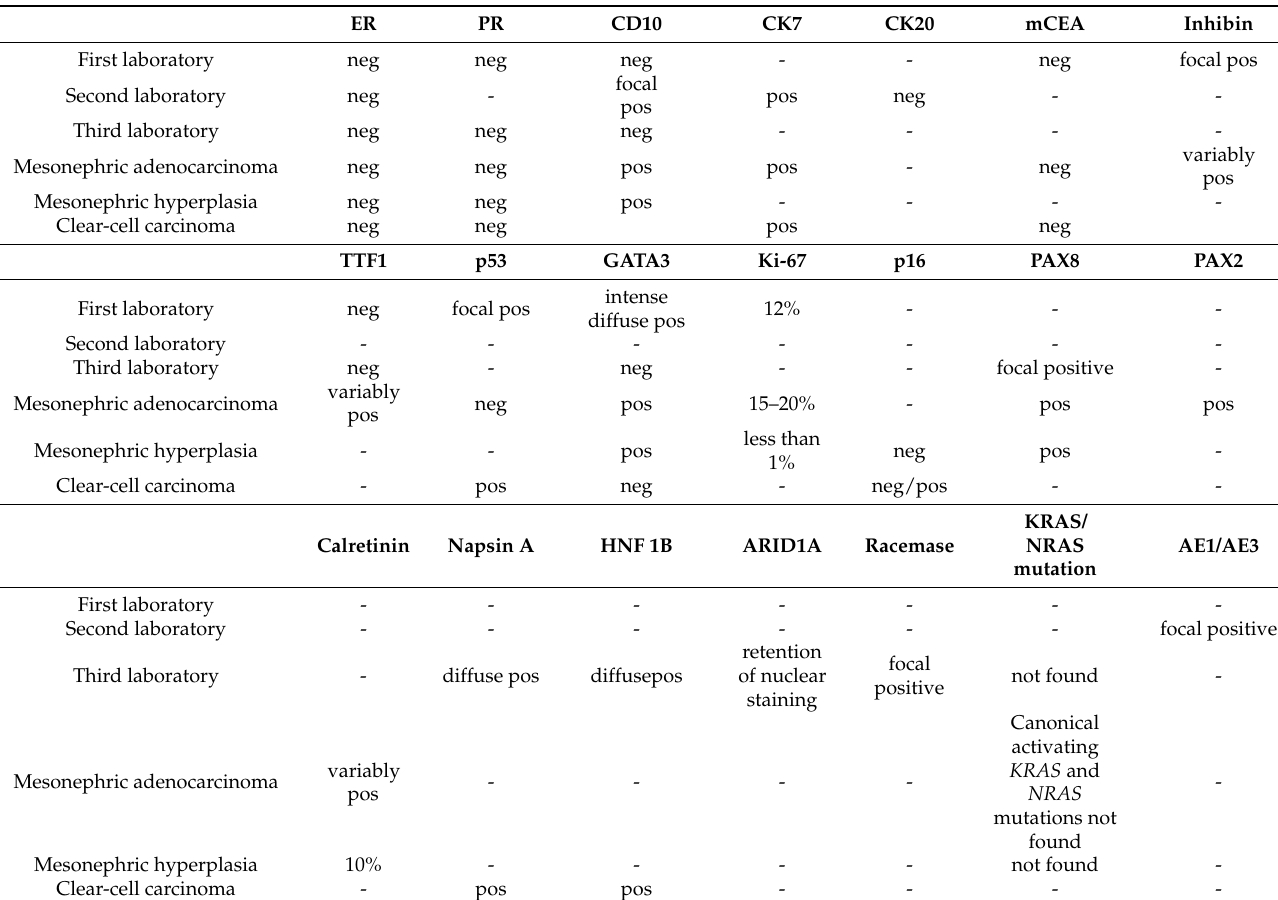
Table 1. Immunohistochemistry (IHC) and molecular features of the specimen compared to results presented in literature for Mesonephric hyperplasia (MH), Mesonephric adenocarcinoma and Clear- cell carcinoma of the cervix [10–16]; Abbreviations: pos = positive; neg = negative; ER =